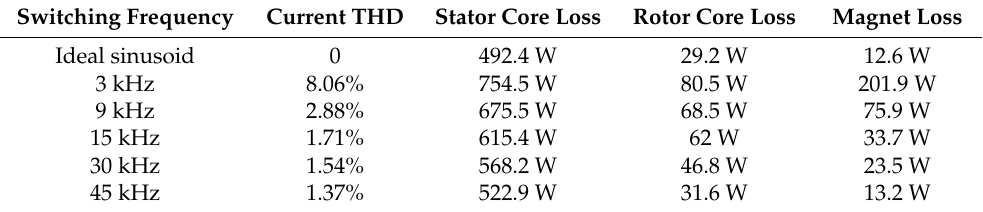
Table 5. Motor loss under different switching frequencies using NFV-SVPWM.